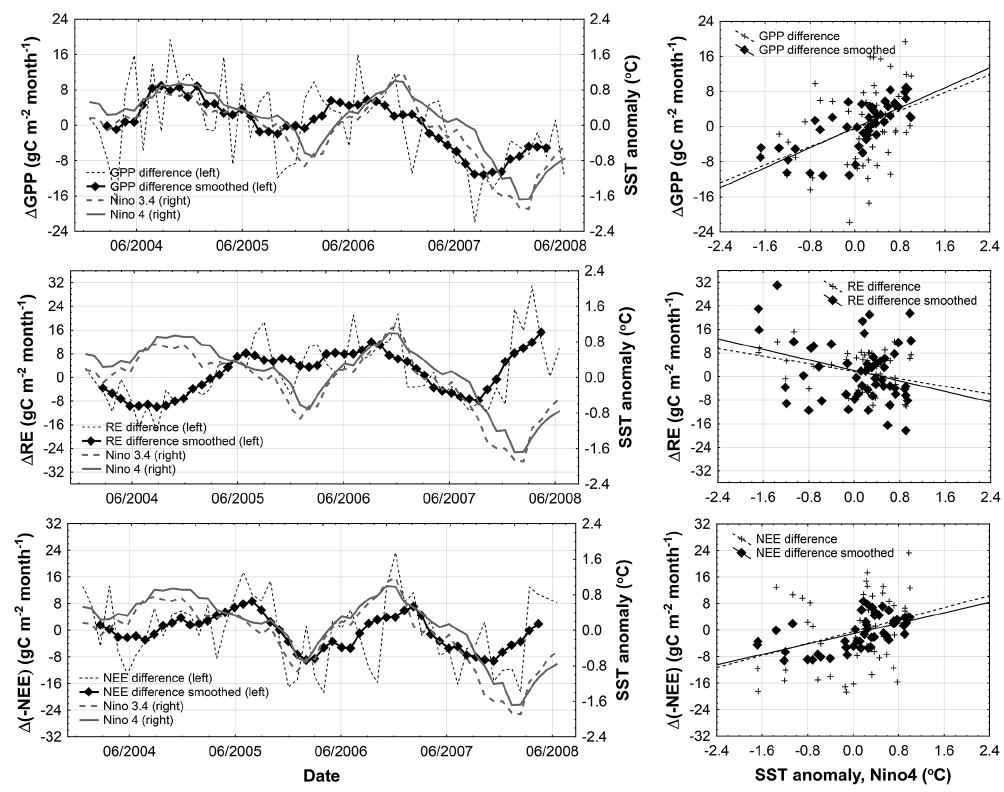
Figure 3. Comparisons of interannual patterns of SST anomalies in Nino4 and Nino3.4 zones of the equatorial Pacific with variability in both deviations and 7-month ( ± 3 months) moving average deviations of monthly GPP, RE and NEE values from mean monthly values of GPP, RE and NEE averaged over the entire measuring period from 2004 to 2008.